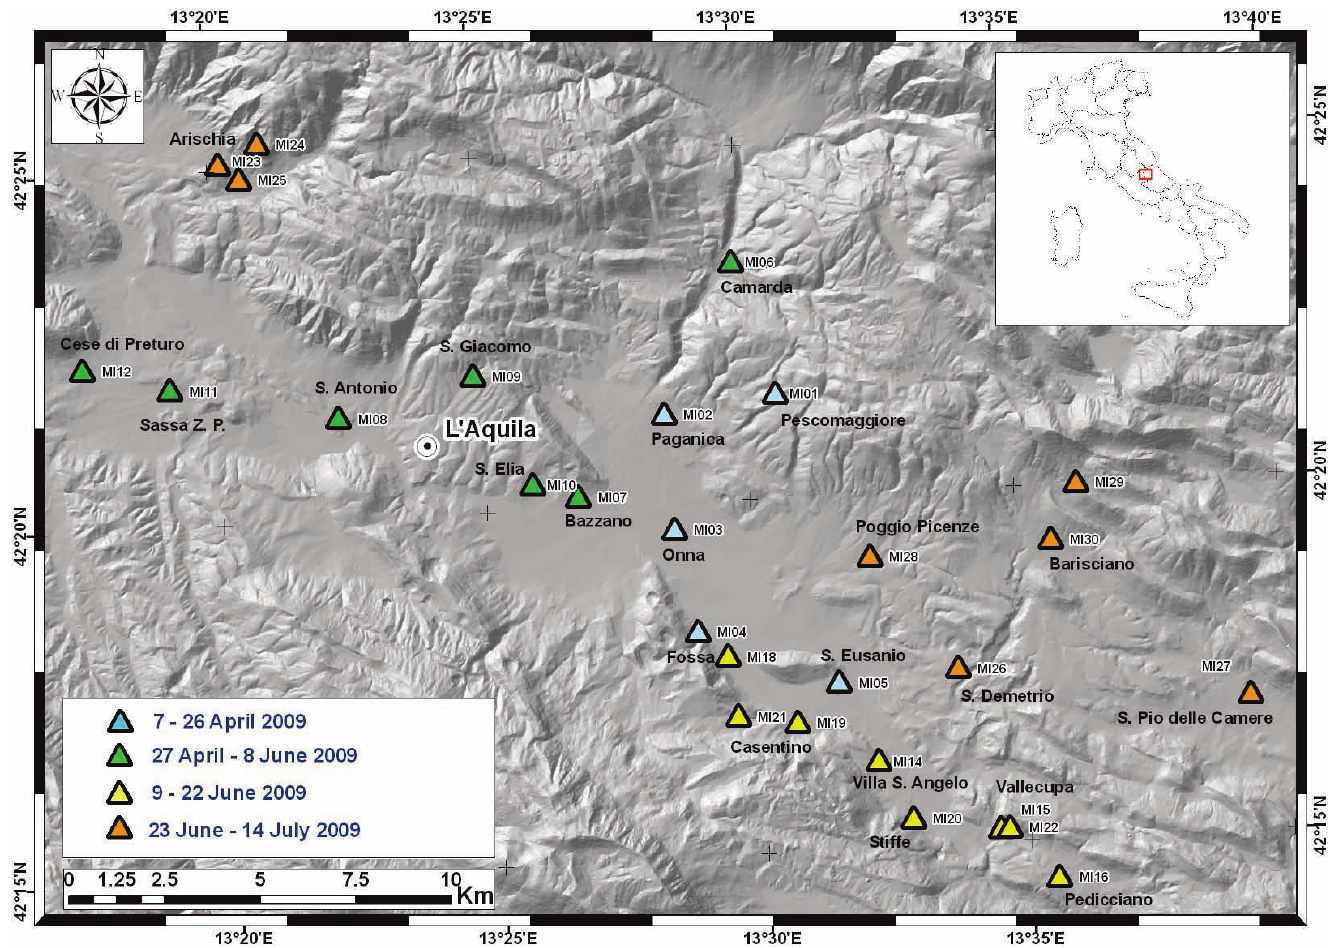
Figure 1. The RAIS-TS stations. The coloured triangles indicate the locations of the temporary stations installed in the different periods (as indicated).